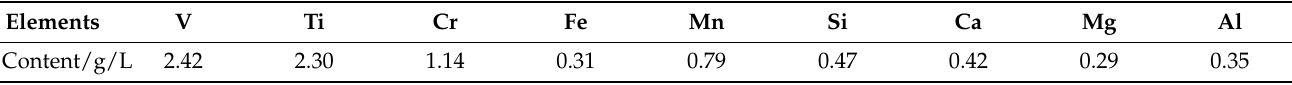
Table 1. Chemical components of the leachate (g/L).